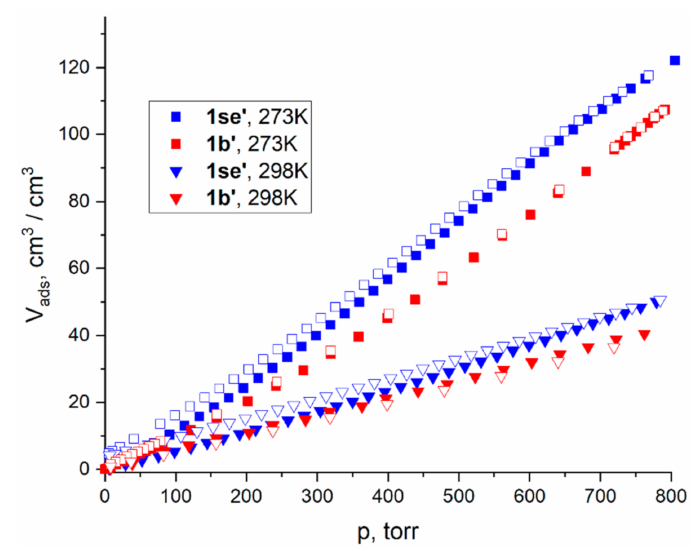
Figure 4. Volumetric CO 2 sorption isotherms for 1se (cid:48) and 1b (cid:48) at 273 K and 298 K.